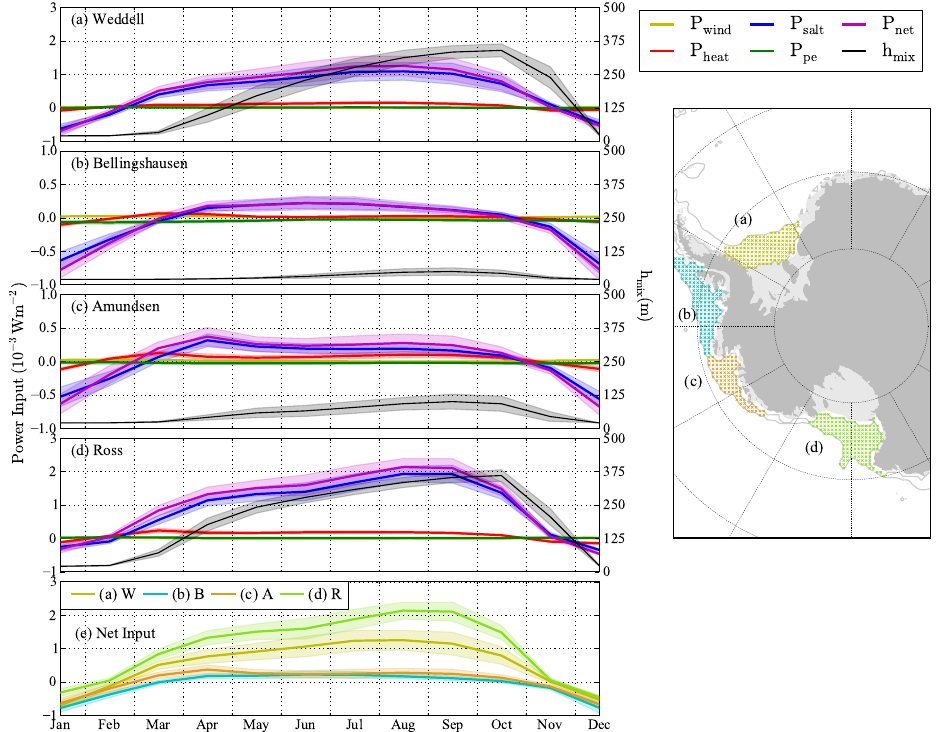
Fig. 11. Mean (1985–2011) surface/mixed-layer (mechanical) power input annual cycle. (a–d) power input from wind mixing (yellow), the ocean/surface-layer heat flux (red), the salt flux from sea ice growth/melt (blue), net precipitation minus evaporation (green), net power input from the addition of all these four terms (magenta) and the mixed-layer depth (black) averaged spatially over each of the four study regions highlighted in the map shown, (e) mean 1985–2011 regional net power input annual cycle. The shading around the lines in (a–e) represents the interannual variability and is equal to one standard deviation from the mean. Table 2. Regional sea ice mass balance contributions, taken from Fig. 13. The errors shown correspond to one standard deviation in the interannual variability. Weddell